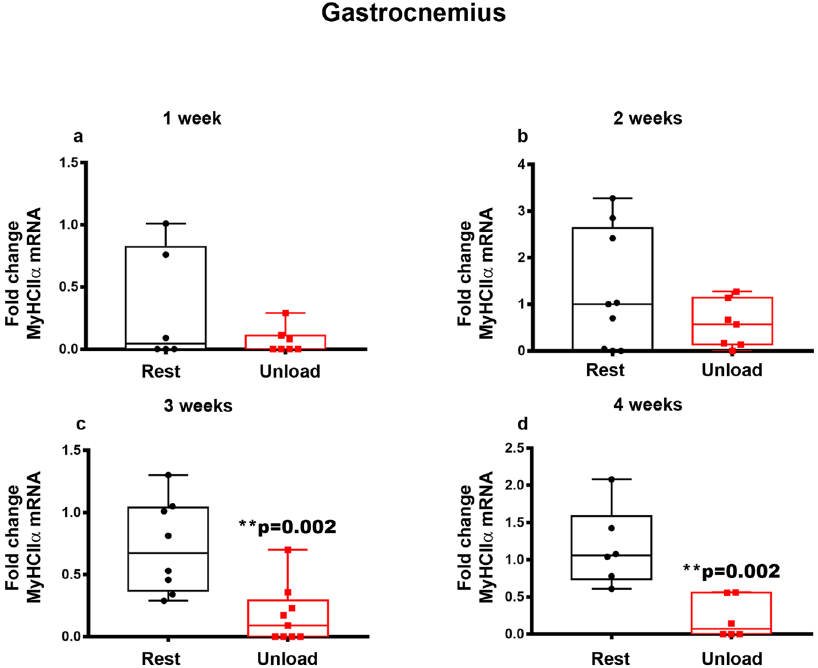
Fig. 4 Effect of unloading on MyHCII α myosin expression in Vastus Lateralis and Gastrocnemius. Quantitative PCR (qPCR) showing mRNA expression levels of MyHCII α in Gastrocnemius ( a – d ) muscle of control mice kept in resting condition (Rest) and HU mice (Unload) at time points 1-2-3 and 4 weeks of suspension. Data showed a signi fi cant decrease of MyHCII α in Gastrocnemius muscle after 3 ( c ) and 4 ( d ) weeks of suspension. Shapiro-Wilk test and Mann-Whitney test were performed. Data are presented as box-and-whisker with median and interquartile ranges, from max to min, with all data points shown. ** p < 0.01 vs (Fig. 10j), and bone cells, speci fi cally osteocytes ( − 44%, * p = 0.037), (Fig. 10k), and osteoblasts ( − 54%; * p = 0.025), (Fig. 10l). Finally, we did not observe any change of the Bcl2/ Bax ratio (Fig. 10m) in myoblast, but we found an increased Bcl-2/ Bax ratio in osteocytes ( + 79%; * p = 0.030) (Fig. 10n) and in osteoblasts ( + 85%; * p = 0.045), (Fig.10o), indicating an anti- apoptotic effect of irisin on bone cell lines.